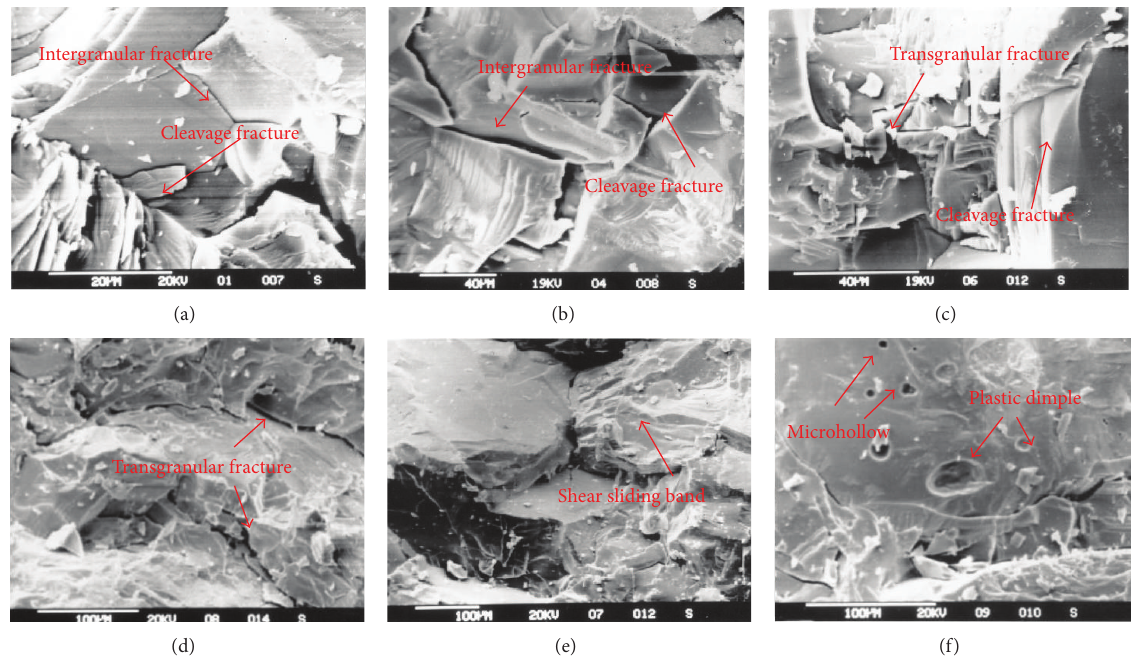
Figure 2: SEM images of fracture surfaces in rock samples under different temperature: (a) 25 ∘ C, (b) 200 ∘ C, (c) 500 ∘ C, (d) 800 ∘ C, (e) 1000 ∘ C, and (f) 1200 ∘